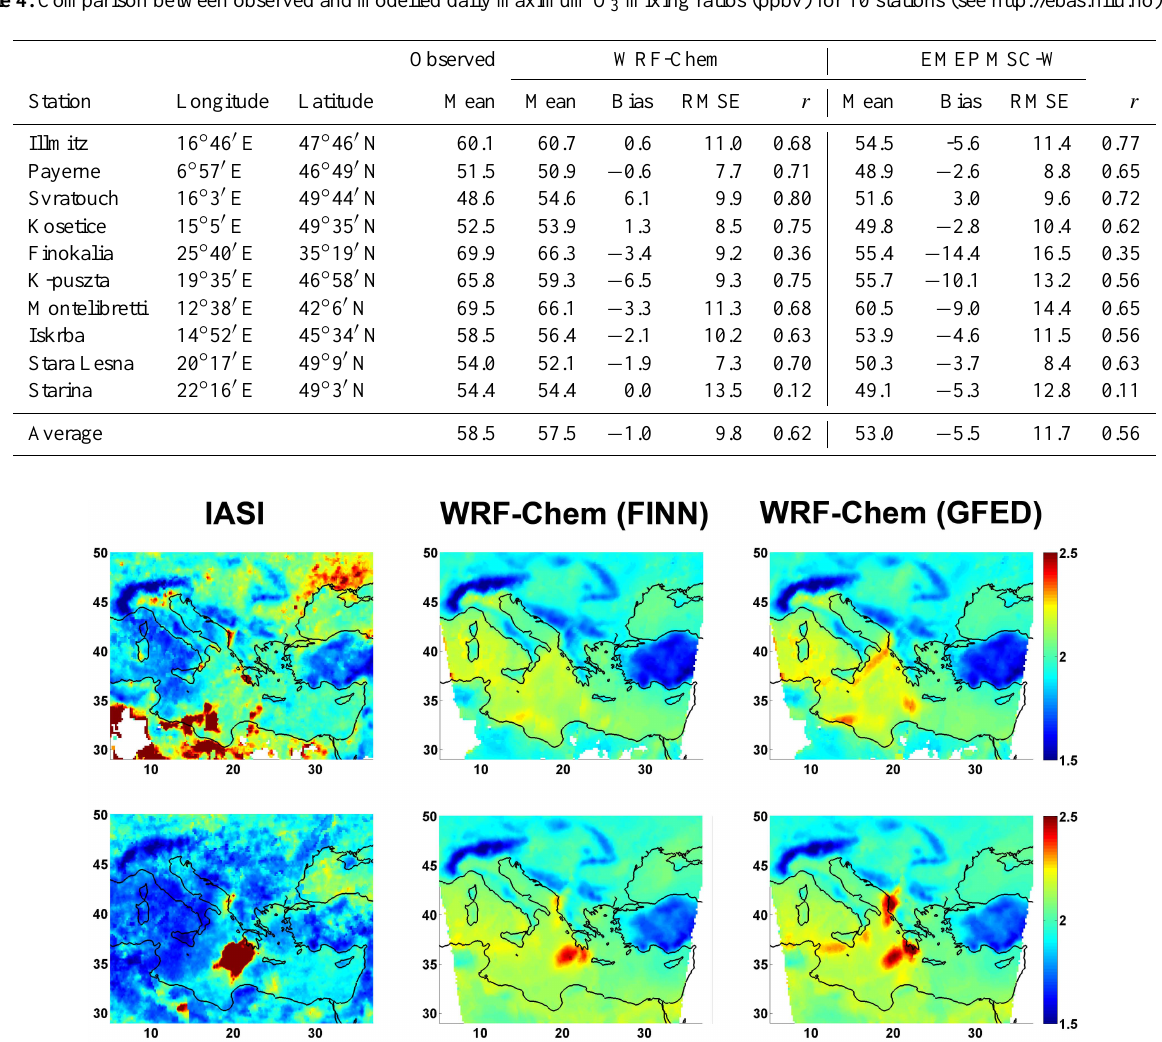
Fig. 6. Kernel weighted total columns of CO (10 18 molec cm − 2 ) as retrieved from the IASI satellite instrument (left), and as modelled with WRF-Chem using FINN (middle) and GFED (right) forest fires emissions. The data are averaged over the period 23–28 August 2007 for daytime (top) and nighttime (bottom) retrievals. The model data have been weighted with the same averaging kernels as the IASI